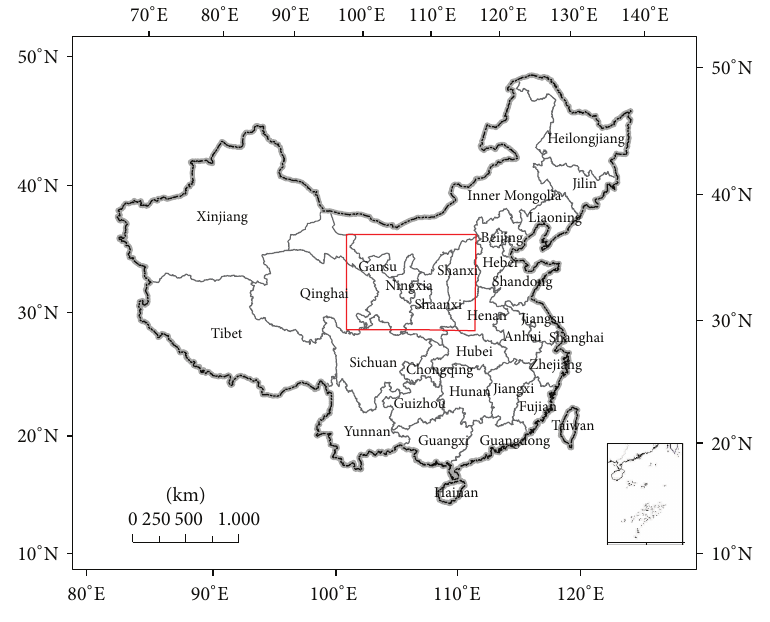
Figure 1: Location of study